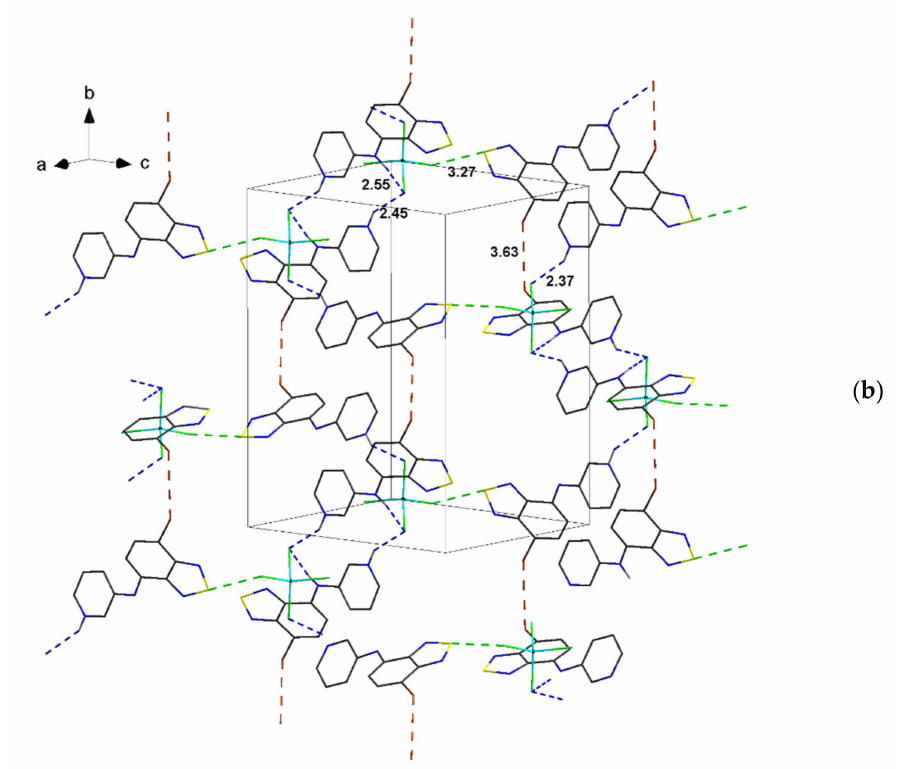
Figure 2. Crystal packing of 2 showing ( a ) π – π interactions (orange dashed lines) and ( b ) Br ··· Br (brown dashed lines), S ··· Cl contacts (green dashed lines) and N 4 H ··· Cl hydrogen bonds (blue dashed lines). Hydrogens except those participating in the hydrogen bonds are not shown.